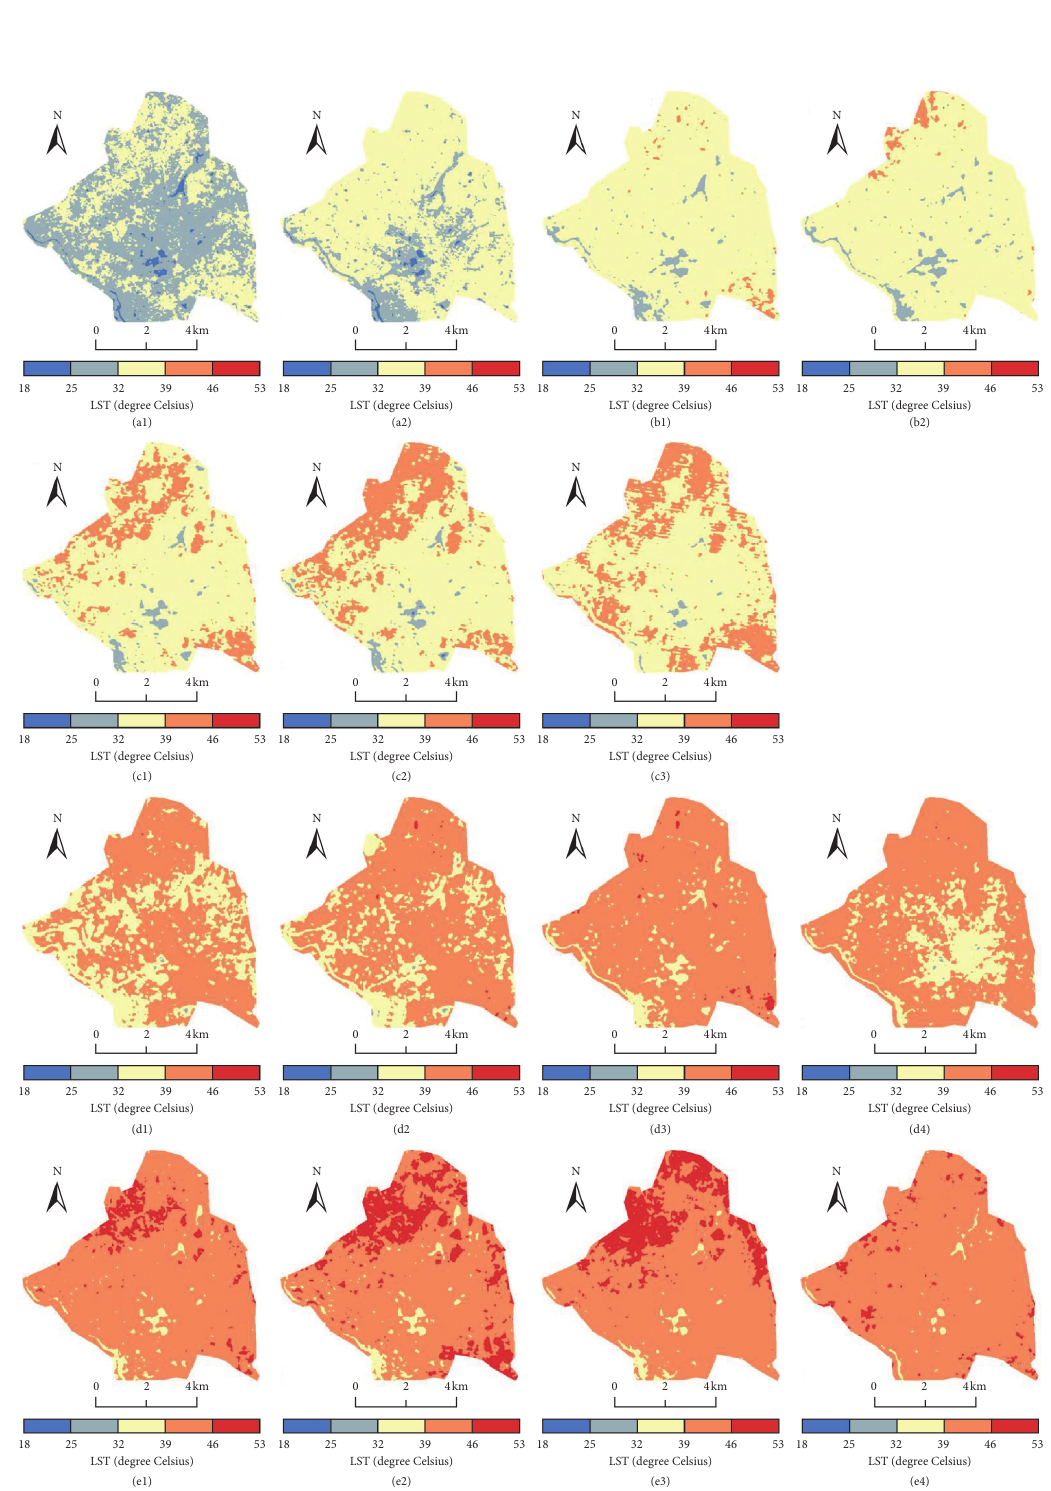
Figure 2: Variation in the distribution of LST ( ° C): (a1-a2) 2002, (b1-b2) 2006, (c1–c3) 2010, (d1–d4) 2014, and (e1-e4)